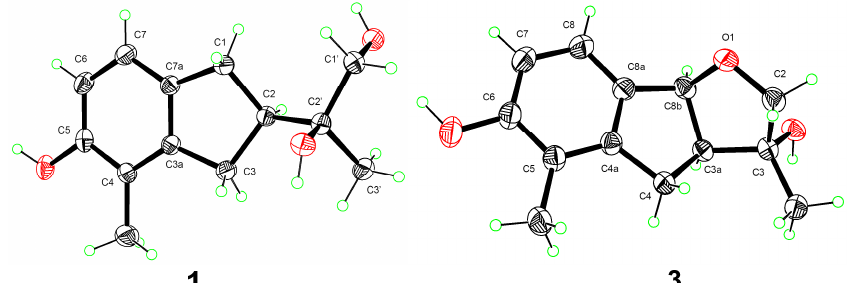
Figure 2. Key 1 H- 1 H COSY and HMBC correlations of compounds 1 – 4 .